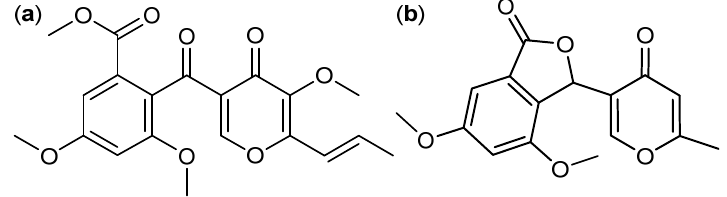
Figure 4. γ -Pyrones: ( a ) 3- O -Methylfunicone and ( b ) Penisimplicissin.